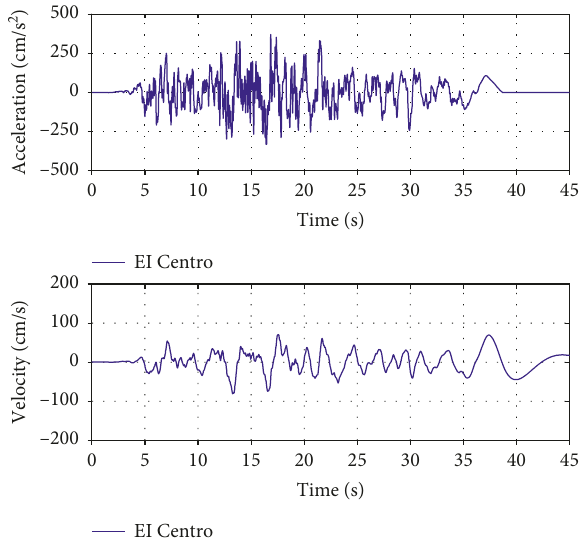
Figure 13: El Centro seismic wave.